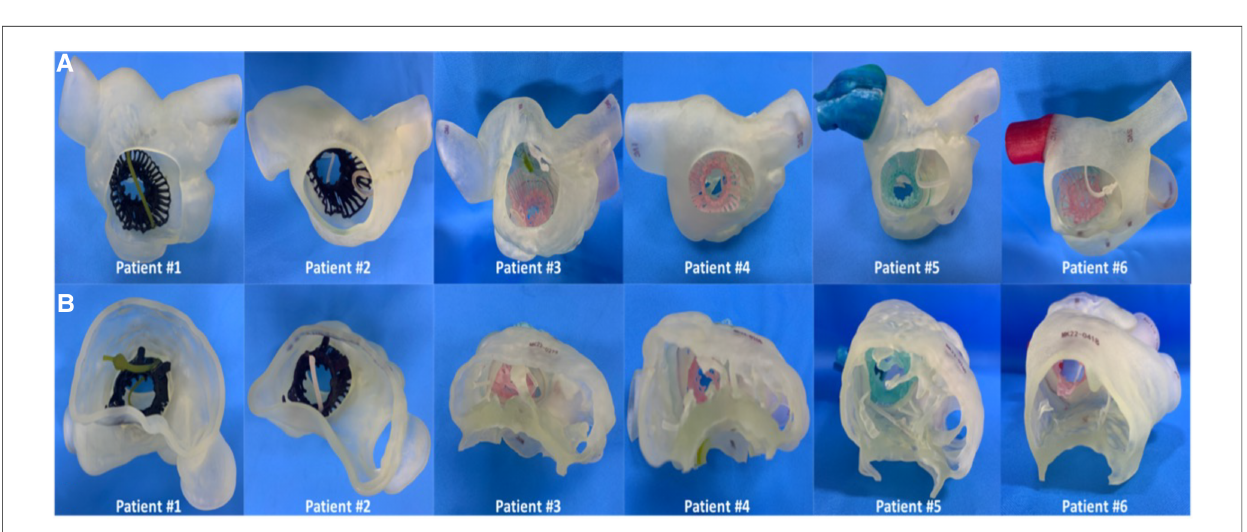
FIGURE 6 The postoperative 3D reconstruction and 3D-printed models of all 6 patients veri fi ed the position of the stented valve, and the lead remained attached to the RV with no change in threshold after the valve was implanted. ( A ) 3D printed model of the patient ’ s right cardiac system in the RA view. ( B ) 3D printed model of the patient ’ s right cardiac system in the RV view. RA, right atrium; RV, right ventricle; 3D,